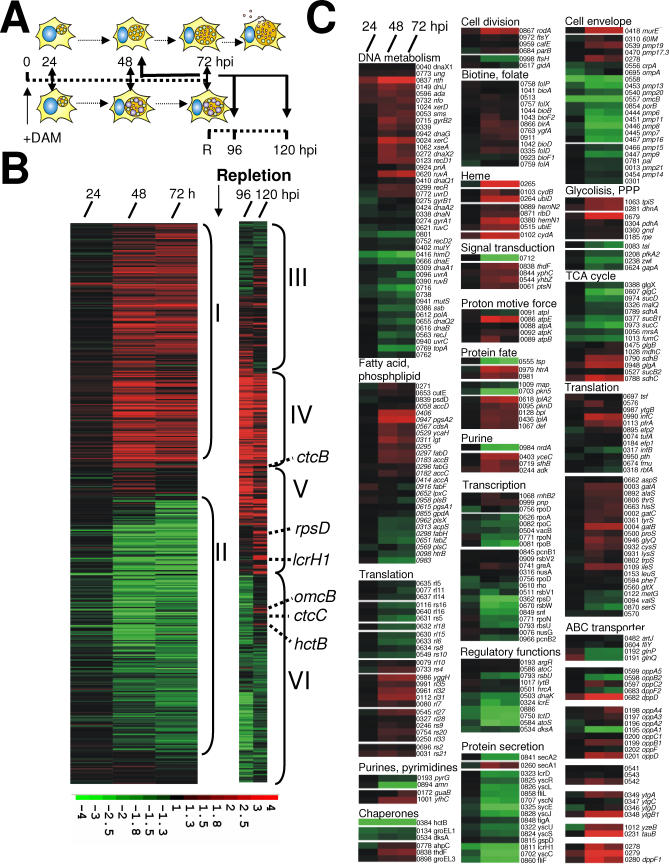
Differentially Regulated Genes during DAM-Mediated Iron-Depleted Persistent Infection(A) Experimental design. Cells were infected with Chlamydia at time point 0, incubated with DAM at 2 hpi to obtain the persistent infection (+DAM), and lysed at 24, 48, and 72 hpi. Iron-depleted cells were repleted at 72 hpi (R) and harvested at 96 h and 120 hpi. Iron-depleted samples were compared with the corresponding time points of the acute infection. Iron-repleted time points were compared with 48 hpi of the acute infection (indicated by arrows).(B) Clustered expression profiles of 461 significantly expressed genes calculated using SAM. Gene expression is displayed in fold change represented by the color bar beneath the figure.(C) Functional grouping and detailed expression profiles of genes differentially expressed during persistent infection are displayed. For expanded annotated details, see Table S3B. Gene identification numbers, gene definitions, and gene names can be viewed at http://www.ncbi.nlm.nih.gov.